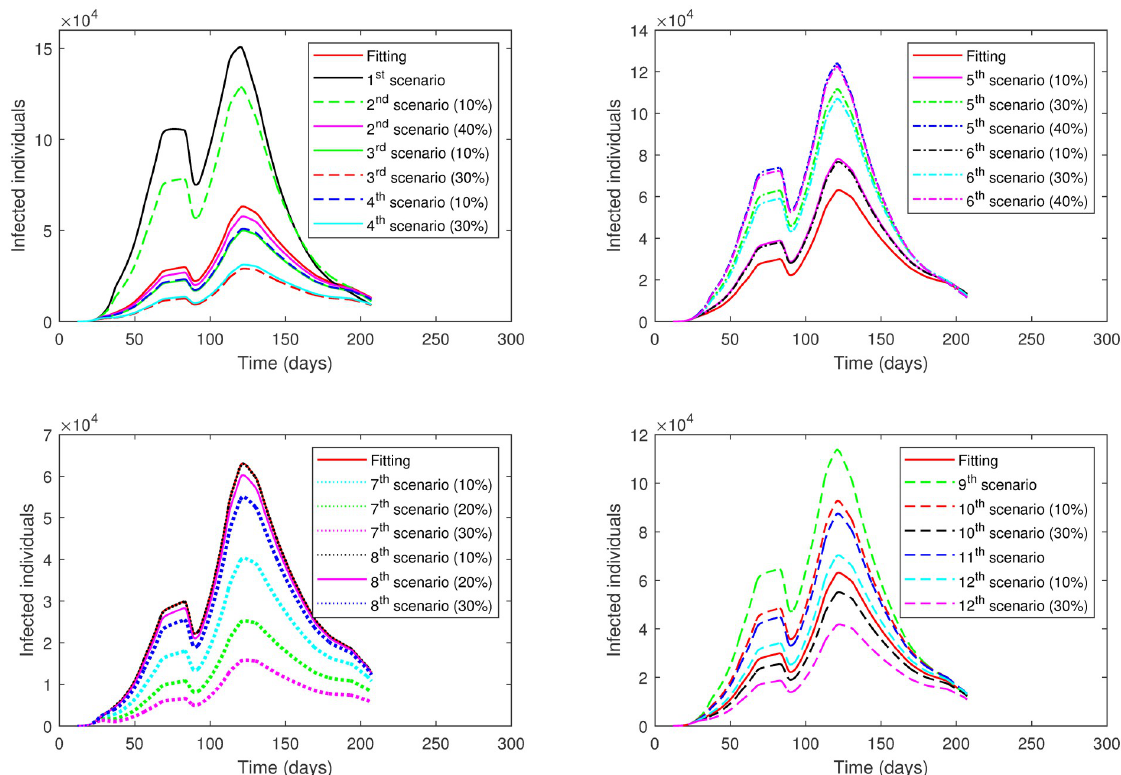
Fig 8. The numerical solution of model (1) for infected compartment vs. time with different scenarios of Phase 2 in the First Case: 1 st scenario, no lockdown is implemented; 2 nd scenario, no lockdown while SD increases; 3 rd scenario, lockdown increases; 4 th scenario, SD increases; 5 th scenario, lockdown decreases; 6 th scenario, SD decreases; 7 th scenario, lockdown and SD increases; 8 th scenario, lockdown decreases and SD increases; 9 th scenario, ρ is the same as in Phase 1; 10 th scenario, ρ is the same as in Phase 1 while SD increases; 11 th scenario, ρ = 0.75 in all Phase 2; 12 th scenario, ρ = 0.75 while SD increases.